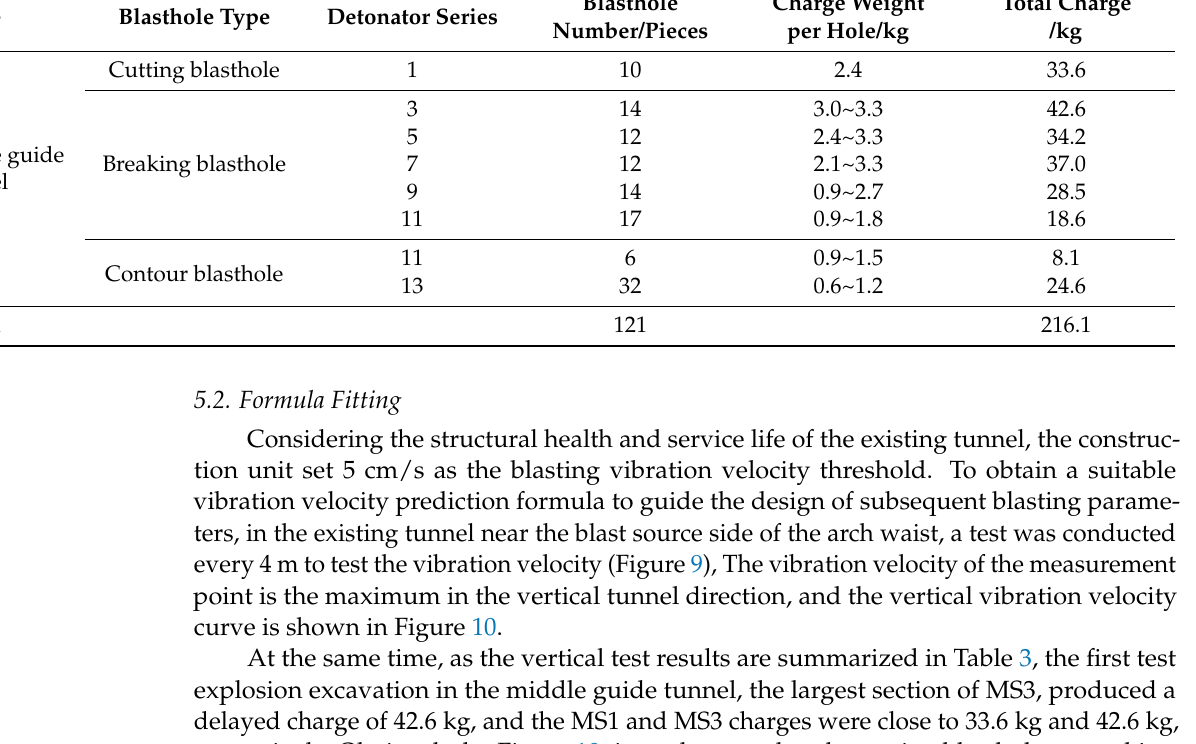
Figure 9. Schematic diagram of measuring point layout.